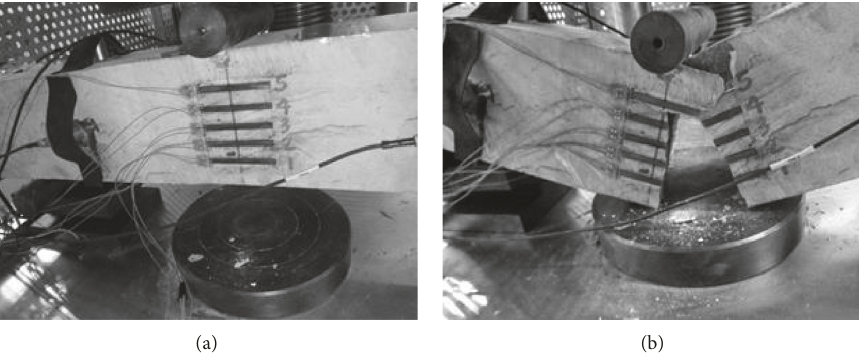
Figure 5: (a) The installed limestone sample. (b) The fractured limestone sample.